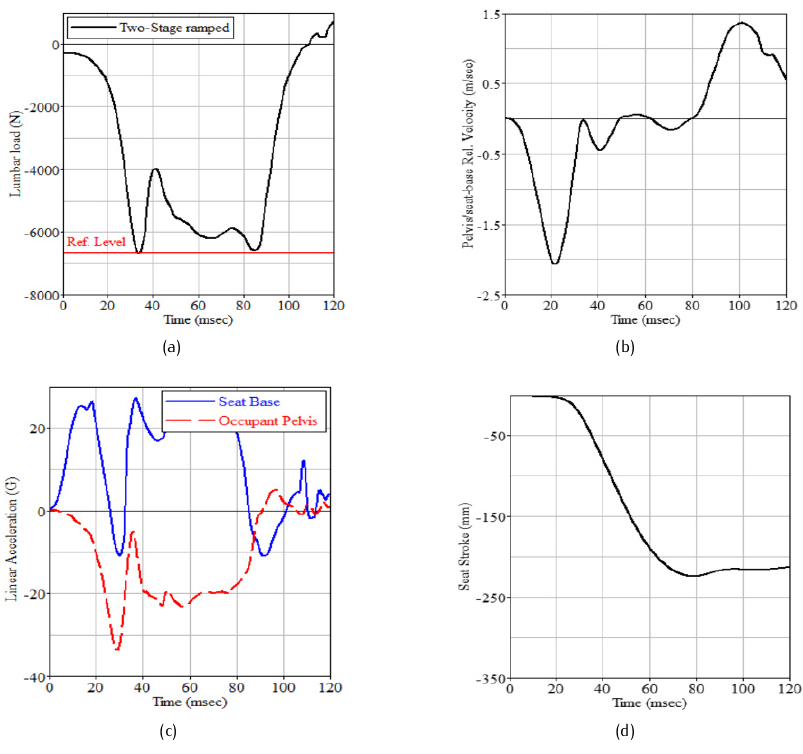
Figure 16. Occupantlumbarload, seat-baseacceleration, seat/occupantrelativevelocity, andseatstroking curve for a two-stage load limiter with ramp.